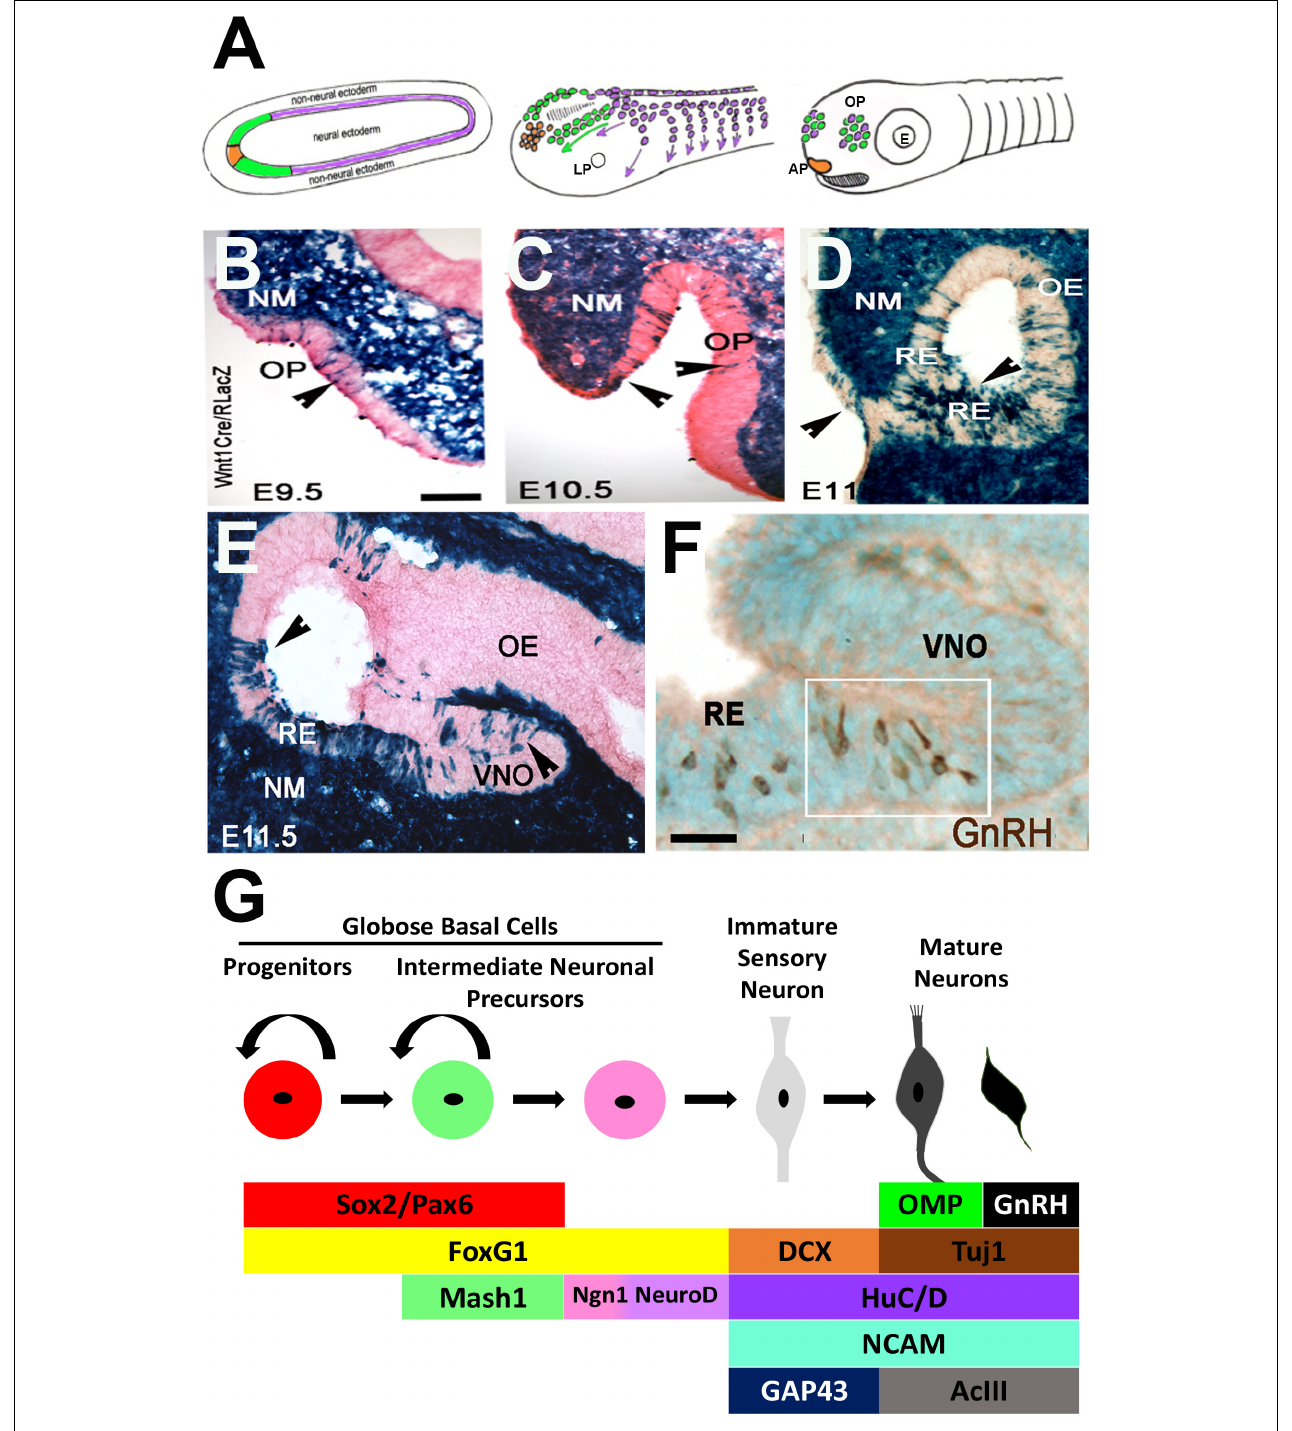
FIGURE 2 | Development of the olfactory system. (A) Schematic of olfactory placode formation. Cell populations at the border of the neural plate: preplacodal ectoderm (green), anterior pituitary placode (orange), and pre-migratory neural crest cells (purple), migrate rostrally and intermix to form the olfactory placodes. (B–E) X-Gal staining on nasal sections of E9.5–E11.5 neural crest reporter mouse (Wnt1Cre/RLacZ) showing Wnt1 expression (blue) in cells within the invaginating olfactory pit (OP, arrowheads), olfactory epithelium (OE), vomeronasal organ (VNO) and throughout the nasal mesenchyme (NM) and respiratory epithelium (RE). (F) Immunocytochemistry staining of E11.5 OE showing GnRH neurons (brown) located at the border between the RE and developing VNO. (G) Schematic of olfactory neurogenesis. Cell types in the OE can be identified by expression of specific factors, which direct cells to remain as cycling progenitors or to undergo neuronal differentiation to form sensory and/or GnRH neurons (Adapted from Whitlock et al., 2006; Forni et al., 2011).